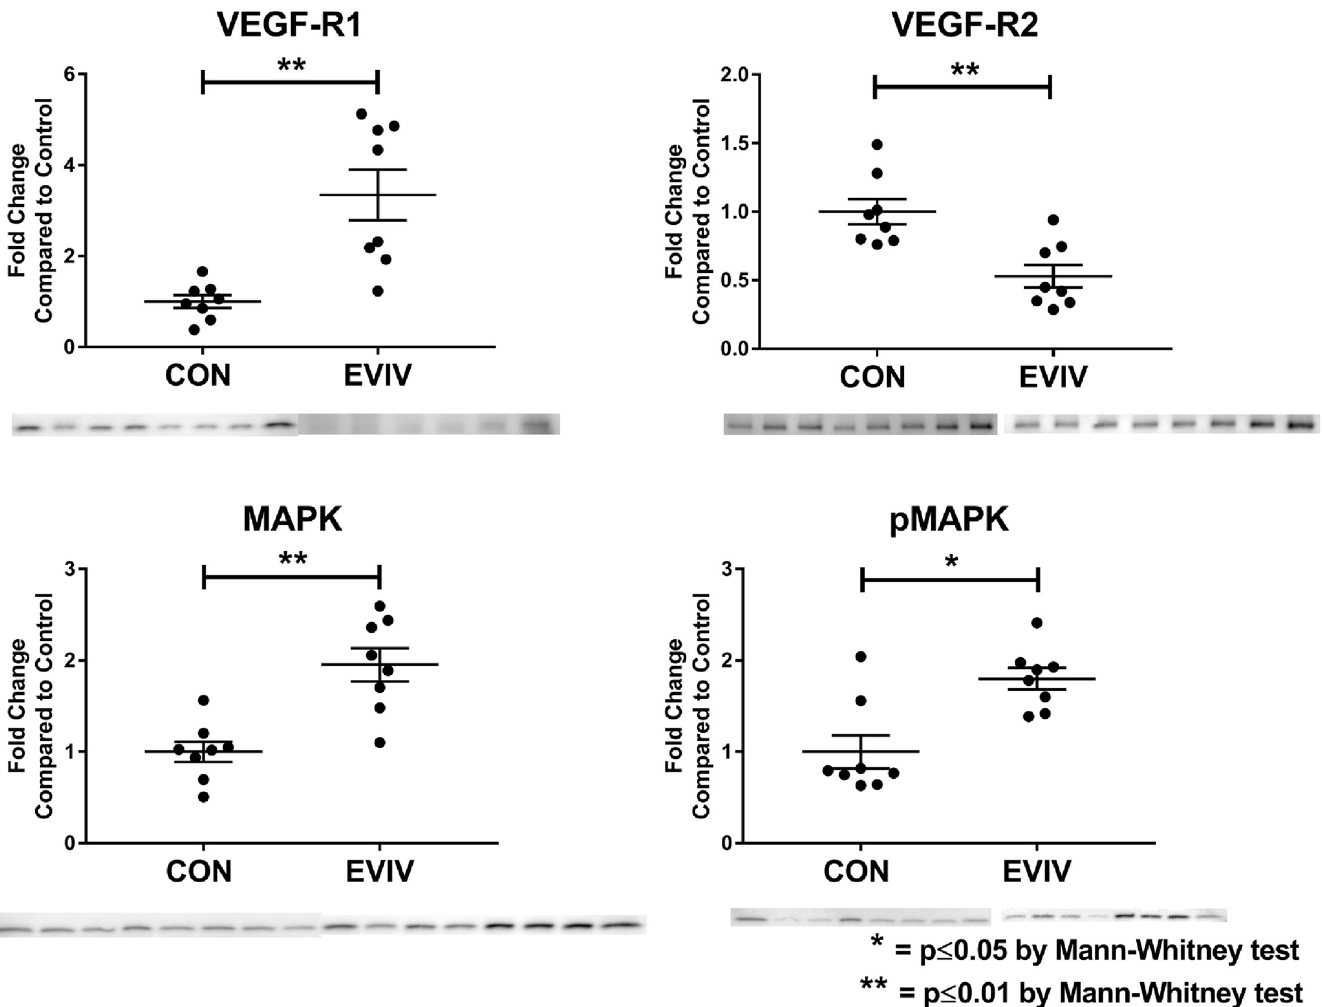
Fig 4. Angiogenesis signaling in the ischemic myocardium. The EVIV group had a significant increase in MAPK, pMAPK, and VEGF-R1. CON: Control group, EVIV: Extracellular Vesicle Intravenous injection group, � p � 0.05 and �� p < 0.01 via Mann-Whitney